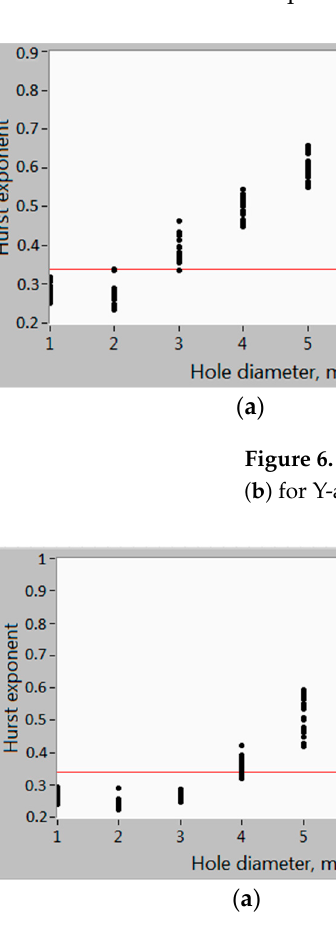
Figure 7. Values of the Hurst exponent at a pump discharge pressure of 2 bar: ( a ) for X-axis signals, ( b ) for Y-axis signals.